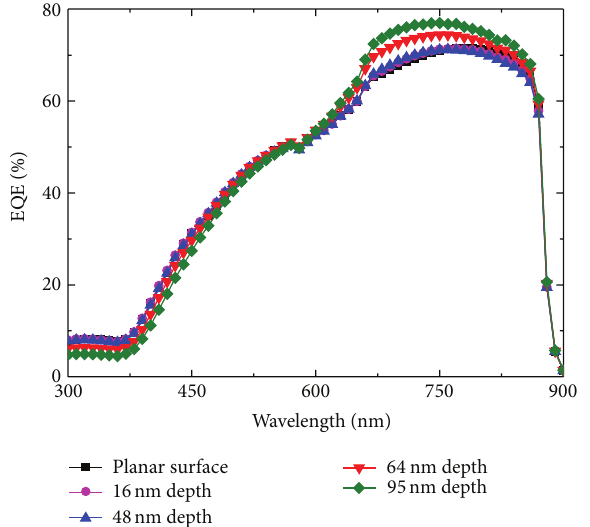
Figure 5: J-V curves of the GaAs solar cells with and without the nanohole